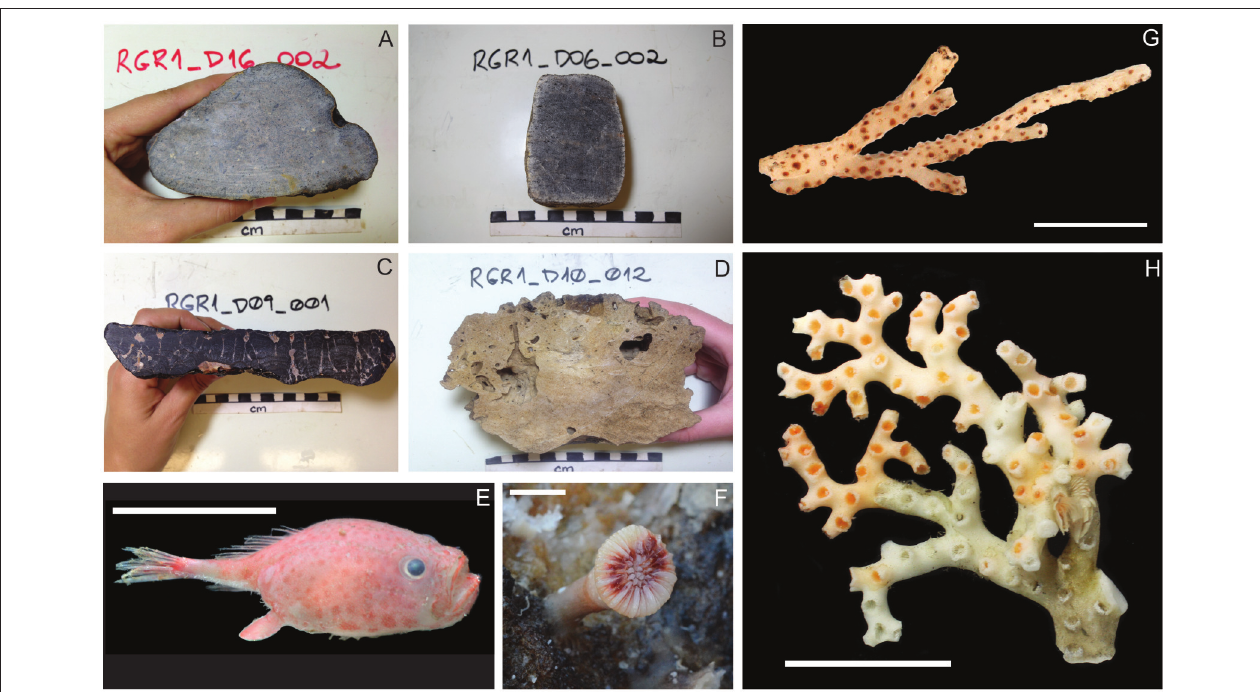
FIGURE 2 | Representative samples of (A) volcanic rock collected in dredge 16, (B) crystalline rock collected in dredge 06, (C) Fe-Mn crusts collected in dredge 09, (D) and calcareous sedimentary rock collected in dredge 10, (E) a dermersal fish Chaunax sp. from dredge 03 (scale represents 50mm), (F) a solitary coral Caryophyllia diomedeae attached to a rock from dredge 17 (scale: 10mm), (G) a branch of sponge Sarostegia oculata from dredge 13 (scale: 32mm), and (H) a branch of coral Enallopsammia rostrata from dredge 03 (scale: